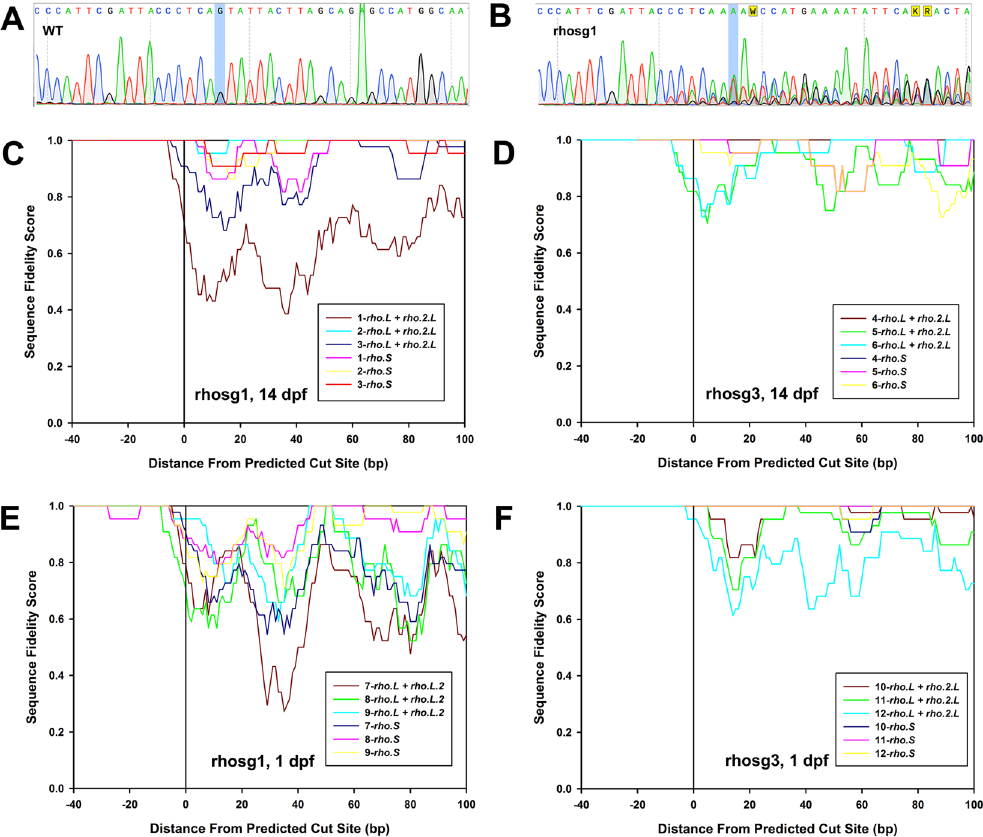
Figure 3. Indels are present in the genomic DNA of F0 animals. ( A,B ) Sample trace reads from dye- termination Sanger sequencing. ( A ) WT sample. ( B ) Edited with rhosg1. Cleavage is predicted to occur after the nucleotide highlighted in blue (numbered “zero” on plots below). ( C – F ) Comparisons of gene editing efficiency between guide RNAs, genes, and stage of development. Calculation of the sequence fidelity score is described under Methods. Each plot shows data derived from three animals, numbered 1–3, 4–6, 7–9 and